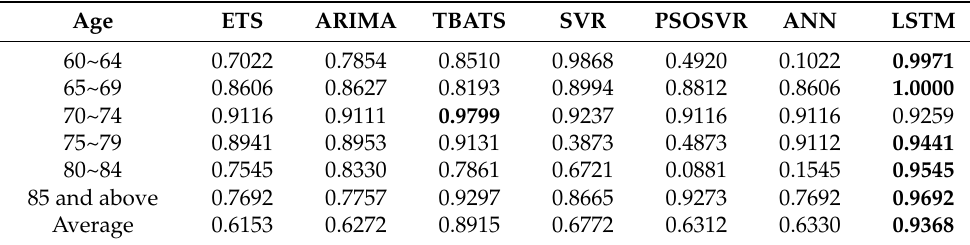
Table 6. R 2 of dementia patients by different